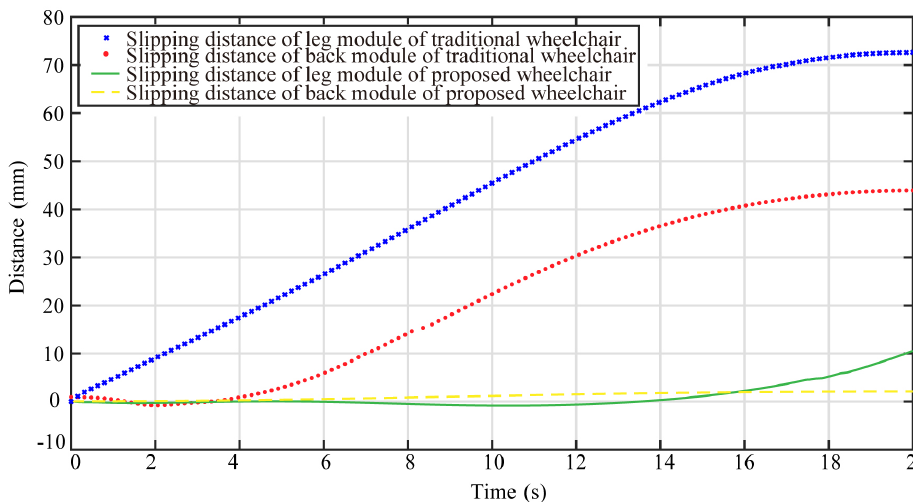
Figure 15. Diagram of the slipping distance of the wheelchair.